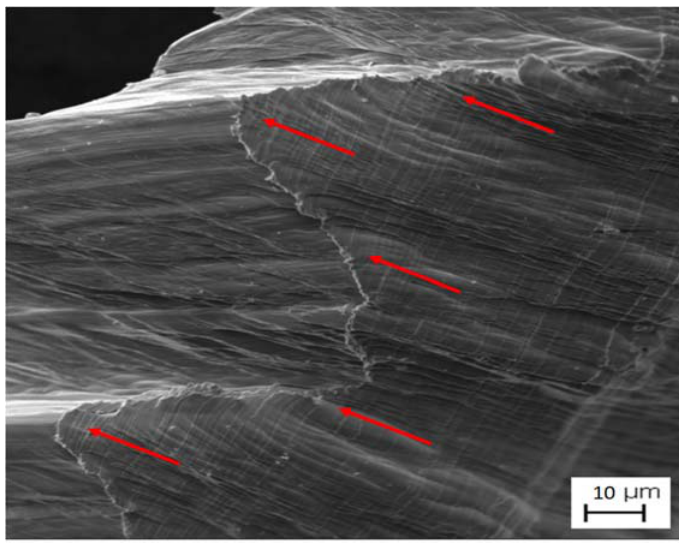
Figure 2. Micrograph of duplex stainless–steel chips, SEM ‐ secondary electron mode. Increased image of the plastic deformation region.